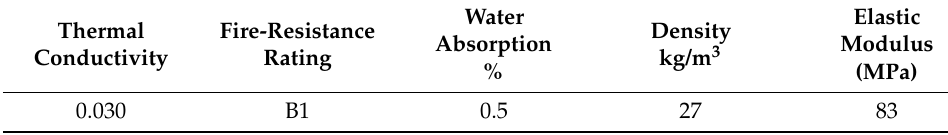
Table 4. The properties of polyphenyl plates.